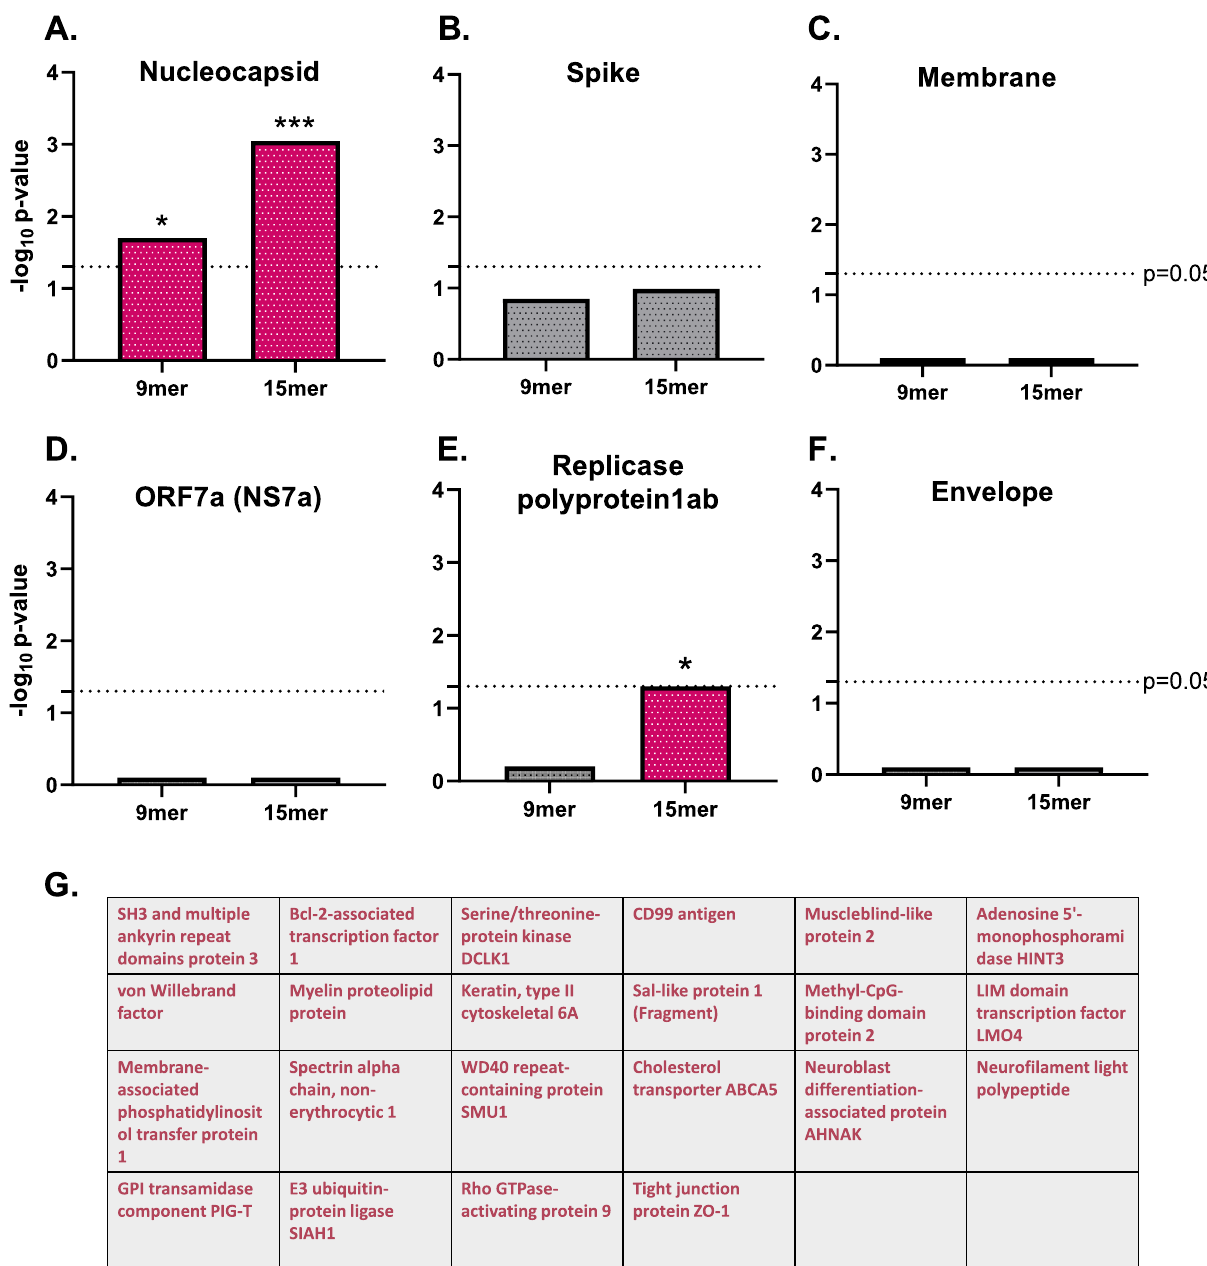
Figure 1. Nucleocapsid protein shares significant homology with MS-associated proteins. ( A ) PEPMatch was used to determine the overlap between nucleocapsid protein from SARS-CoV-2 and MS-associated proteins, which were determined using an IEDB query. For comparison, 30 iterations of shuffled-sequence nucleocapsid protein were run through the analysis with the same parameters as the intact nucleocapsid sequence, whose average was then compared to MS-associated proteins. Fisher’s exact or Chi square tests were run on both the 9mer and the 15mer peptides, with up to 2 mismatches for the 9mer peptides and up to 7 mismatches for the 15mer peptides. ( B – F ) The same analysis was run as in ( A ) using the specified proteins labeled above each graph from SARS-CoV-2. ( G ) Shown are the proteins whose peptides significantly overlapped with nucleocapsid across both the 9mer and 15mer